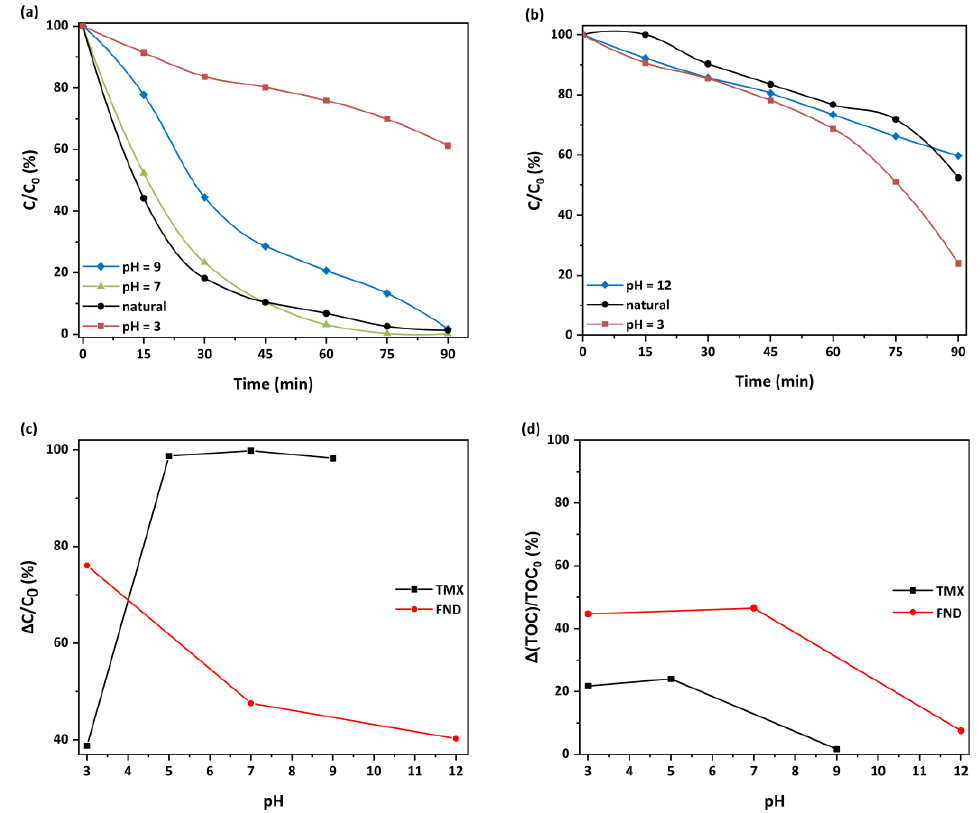
Figure 3. Effect of solution pH on the photocatalytic removal of ( a ) thiamethoxam (TMX) and ( b ) flonicamid (FND); ( c ) Comparative representation of medium pH effect on photocatalytic effi- ciency; and ( d ) total mineralization for both pesticides after 90 min UV-A